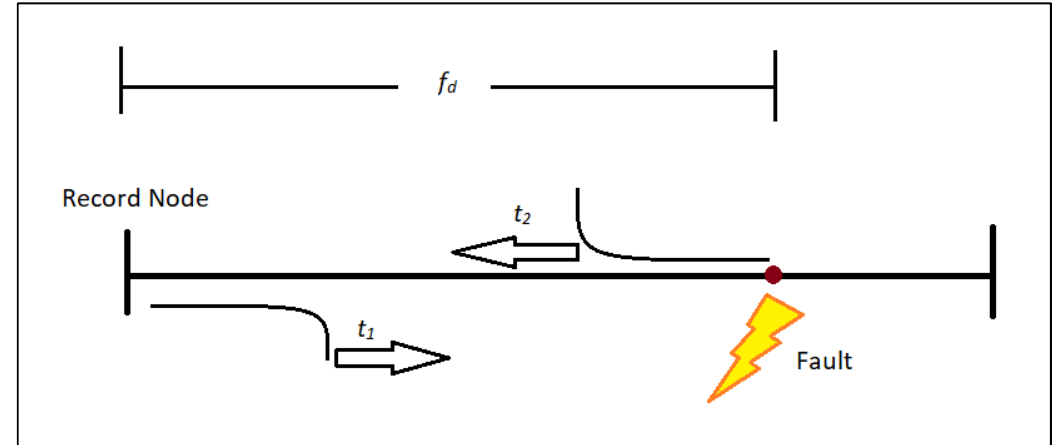
Figure 6. Travelling wave method.